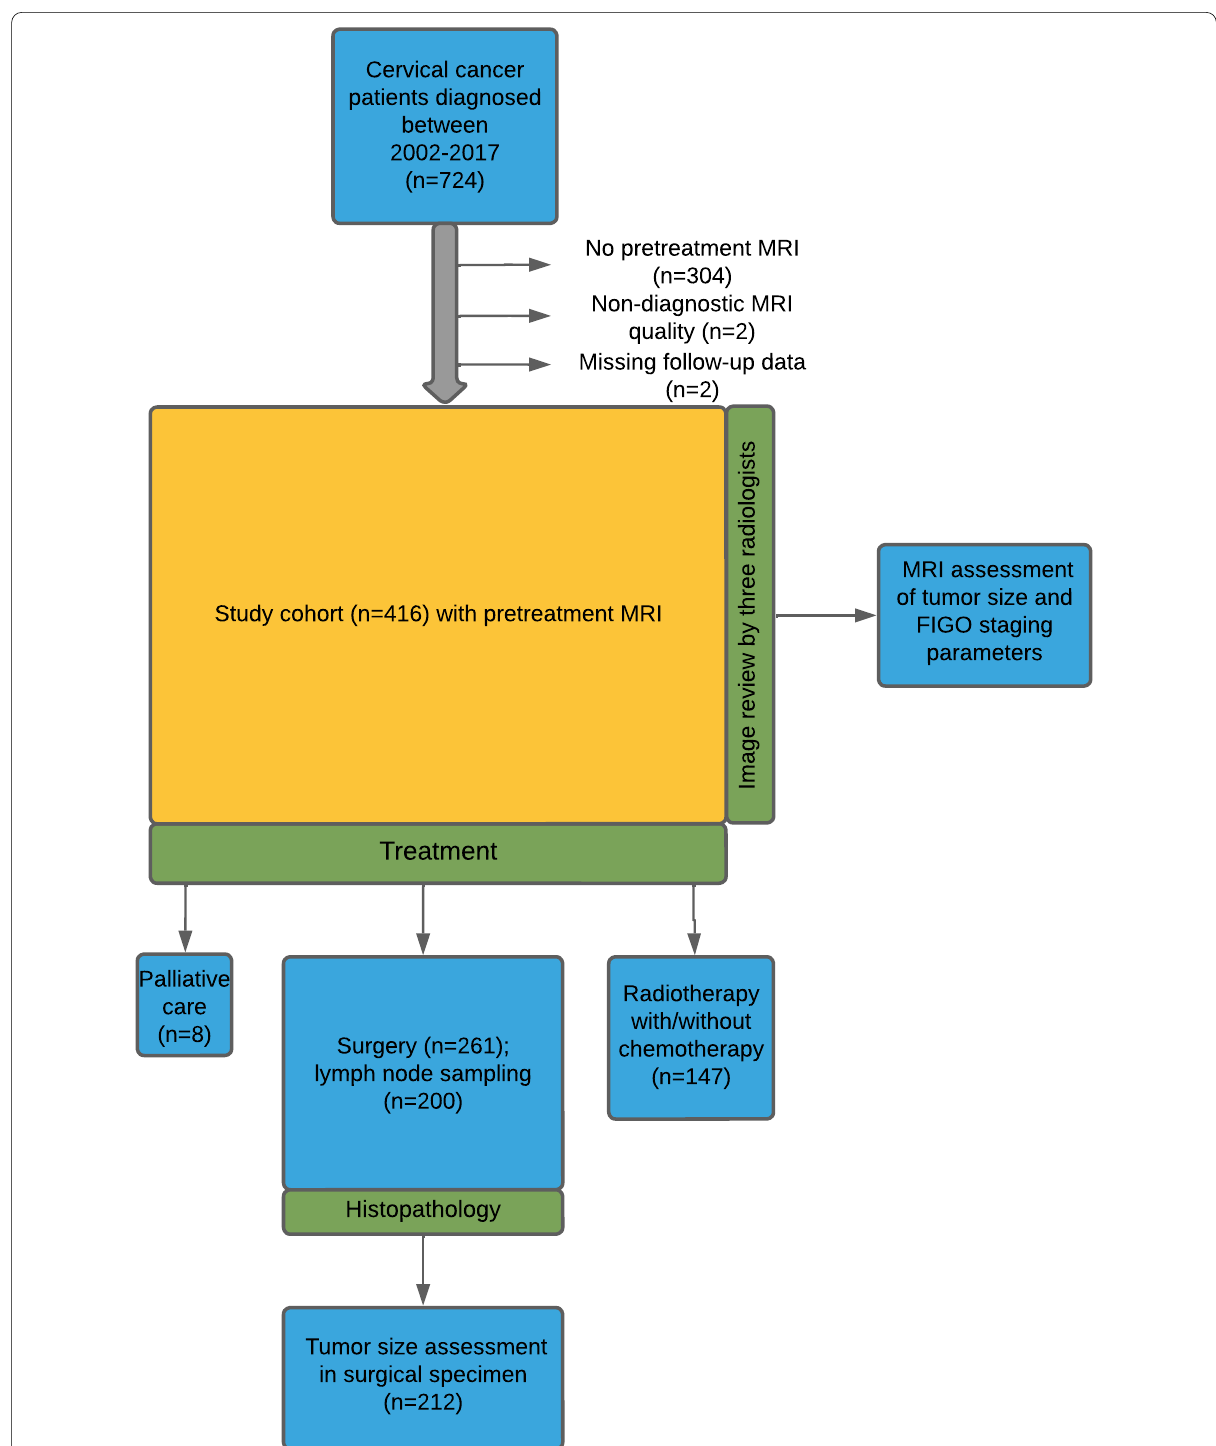
Fig. 1 Flowchart illustrating patient inclusion and study setup, including MRI review with tumor size measurements and histological assessment of tumor size in a subgroup of surgically treated